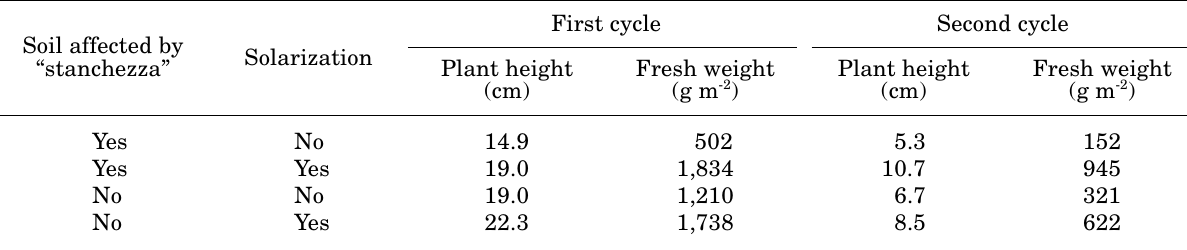
Table 4. Effect of bench solarization on “stanchezza” (soil sickness) of sweet basil. Results are expressed as plant height (cm per plant) and f wt (g m -2 ) of the aerial plant organs 30 days after sowing on August 20, 1996 (Trial 4, first cycle) and on October 1, 1996 (Trial 5, second cycle).